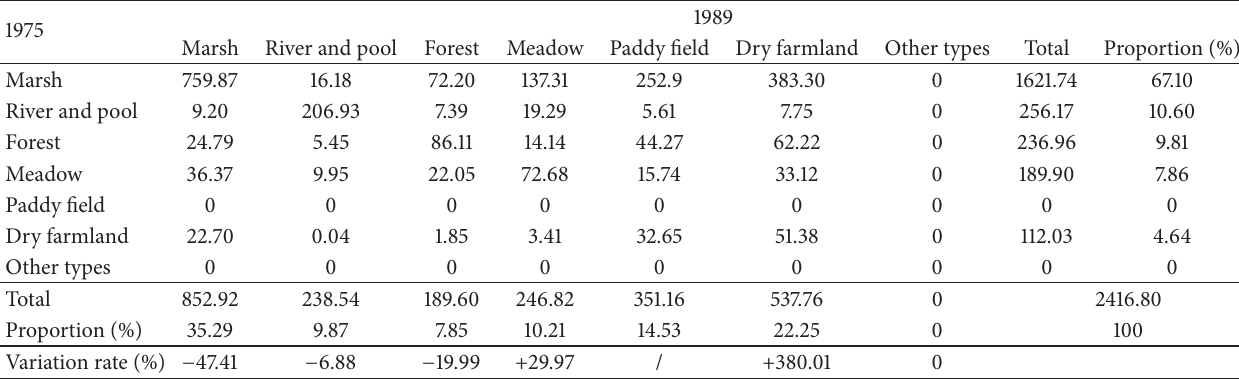
Table 1: Transformation matrix of landscape and land use within the study area during the period from 1975 to 1989 (unit: km 2 ).